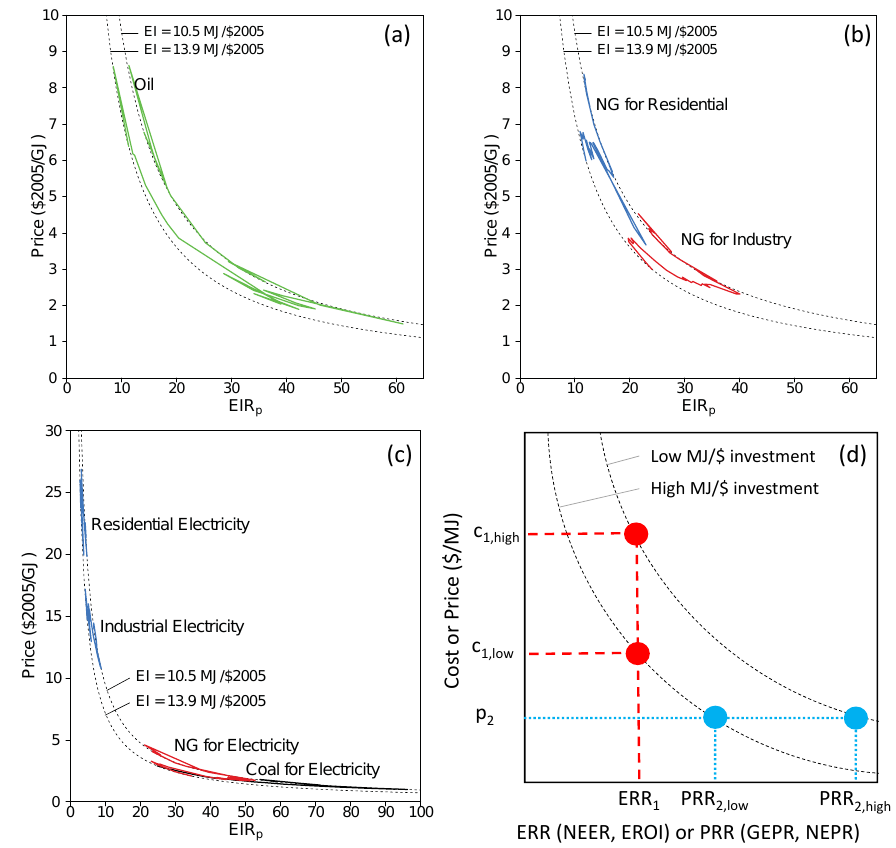
Figure 8. Price vs. EIR p for the 44-country “world” aggregate prices, weighting each country price n by the country GDP, for: ( a ) oil; ( b ) natural gas; and ( c ) electricity, along with the price of coal and NG purchased by electric generators; ( d ) the subfigure shows that depending on the characteristics of the required inputs (money and/or energy) for the energy supply chain or life cycle, a calculated ERR or PRR can relate to a range of prices, or vice versa